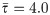
Interspike time- and frequency-count histograms of a single-cell record.(A), (C) Interspike time histograms f(δt) and f(δτ) before and after time rescaling, respectively. (B),(D) Frequency-count histograms P(k) (for a time-interval of T = 2.7 s width) and P(κ) (for a rescaled time-interval of τ¯=4.0 width) before and after time rescaling, respectively. The histograms f(δt) and f(δτ) are fitted with gamma (solid lines) and exponential distributions (dashed lines). The frequency-count histograms P(k) and P(κ) are fitted with the gamma-count (see text, solid lines) and Poisson distributions (dashed lines). The number of spikes was 914. Inset plots in (A) and (C) show the spike rates of the original and time-rescaled spike series, respectively.